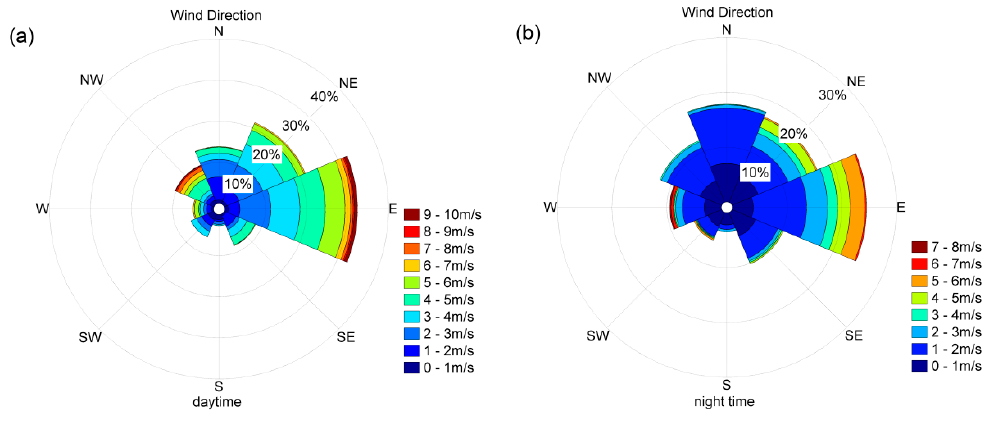
Figure 4. Temporal variations of ( a ) wind speed at 3-, 5-, 8- and 10-m heights (lines), ( b ) air temperature at 3-, 5-, 8- and 10-m heights, ( c ) relative humidity at 3-, 5-, 8- and 10-m heights, ( d ) surface atmospheric pressure and ( e ) precipitation from 12 September–11 October 2015.